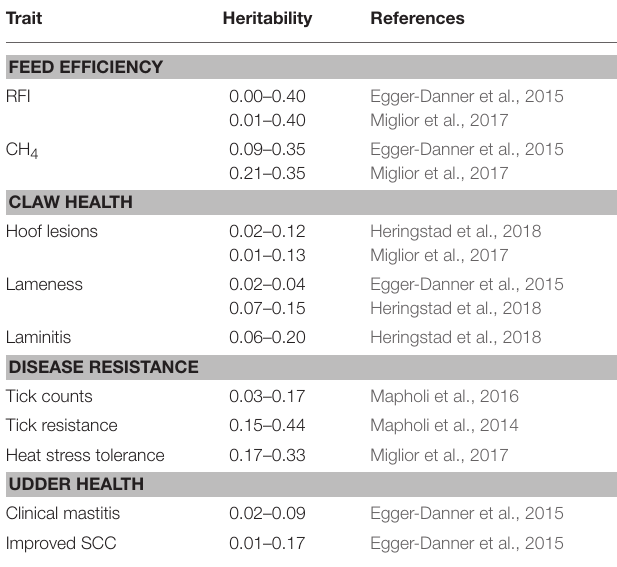
TABLE 3 | Proposed novel traits for inclusion in selection